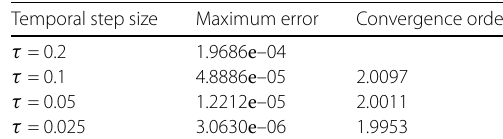
Figure 12 The error of ADI-CFDS4 at t = 2, with h x = h y = 0.02 π and τ = 0.02 for SP